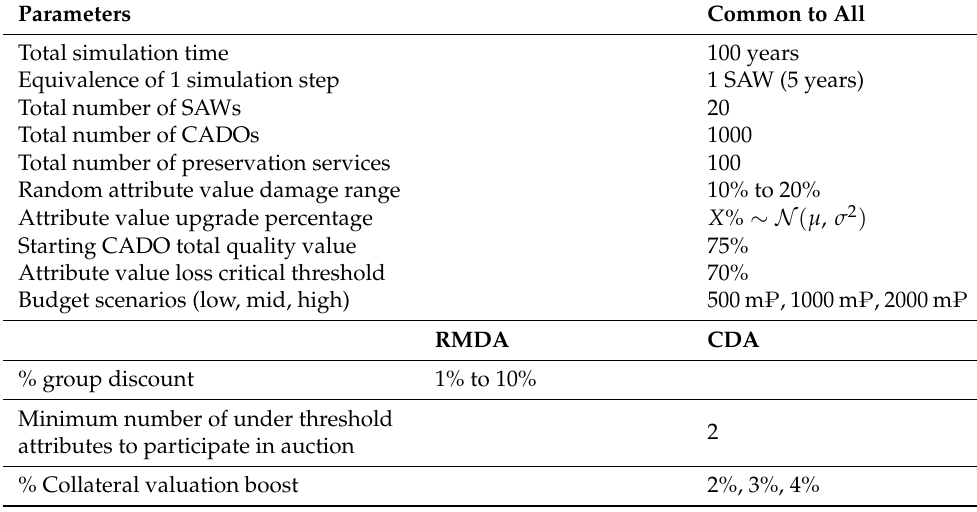
Table 1. Definition of the initial parameters used in the TiM simulations for every